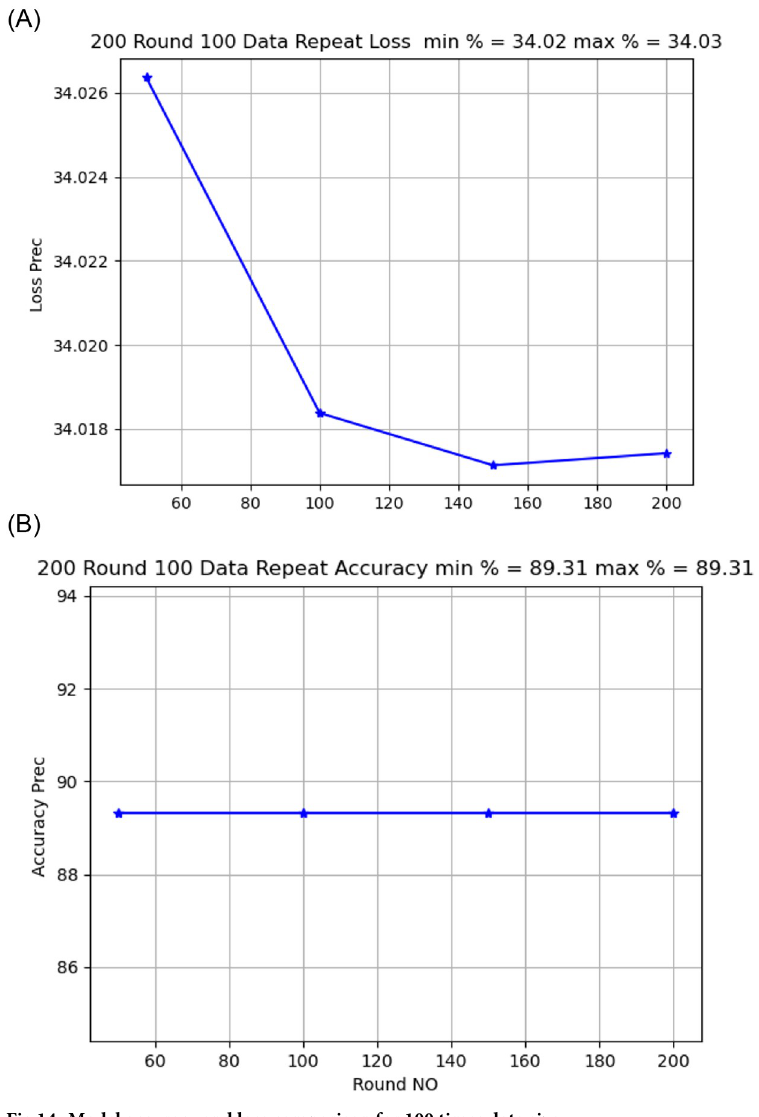
Fig 14. Model accuracy and loss comparison for 100 times data